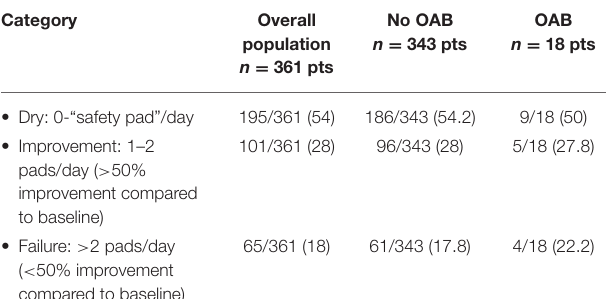
TABLE 4 | Postoperative degree of stress urinary incontinence of the patient population ( n = 361 patients); percentage. Category